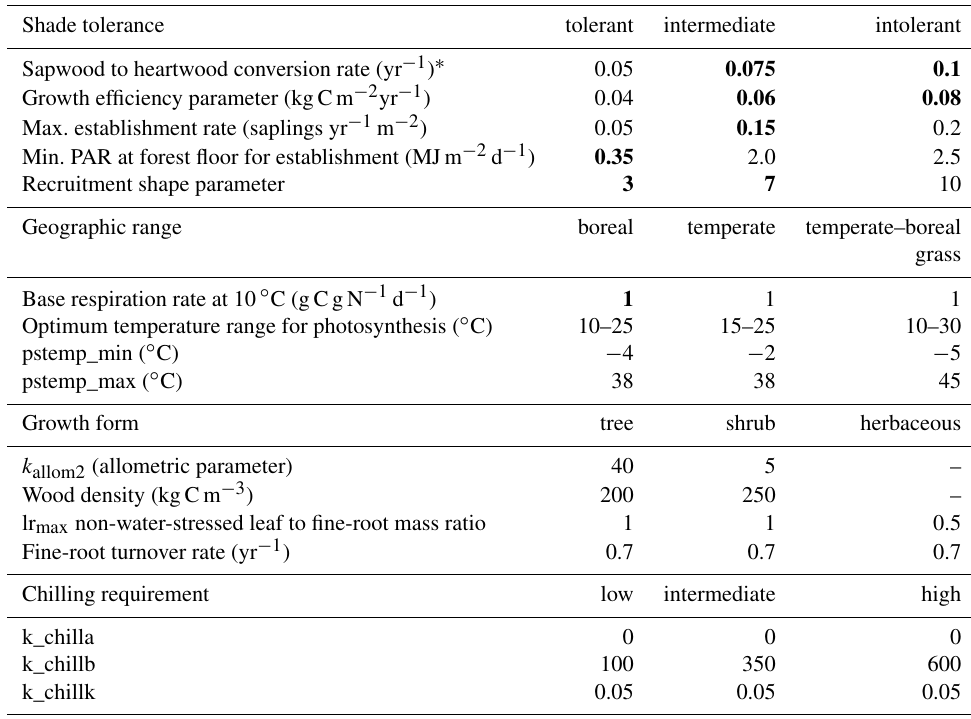
Table A2. Common PFT parameters for shade tolerance, geographic range, growth form, and chilling requirement categories in Table A1. Values in bold text are updated compared to Hickler et al. (2012).